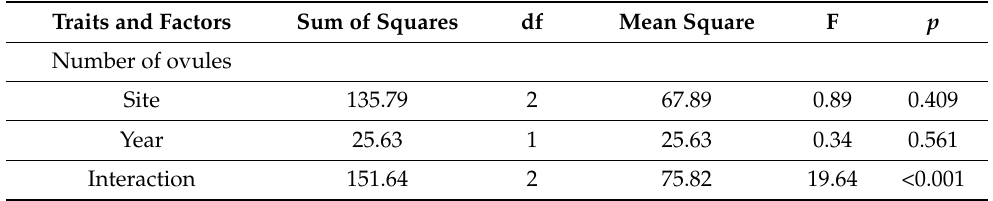
Table 4. Summary of the two-way ANOVA analyses of the relationships of Cytisus scoparius repro- ductive traits with the site (fixed factor) and year (random